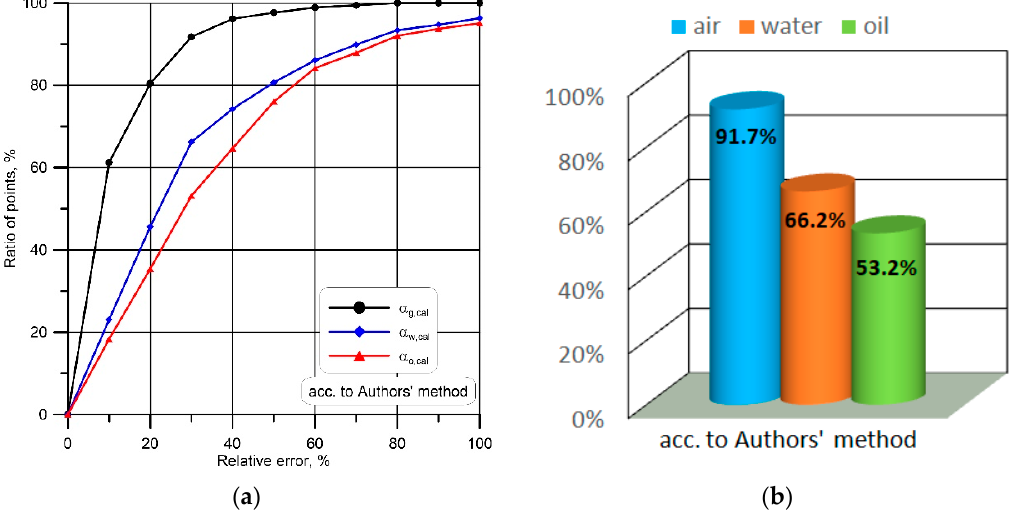
Figure 11. Statistical analysis of the method applied for determining the values of void fraction of phases for downward three-phase oil–water–air flow ( a ), and ( b ) values of experimental points in the boundary of < 30% of the MAE in accordance with the proposed method.